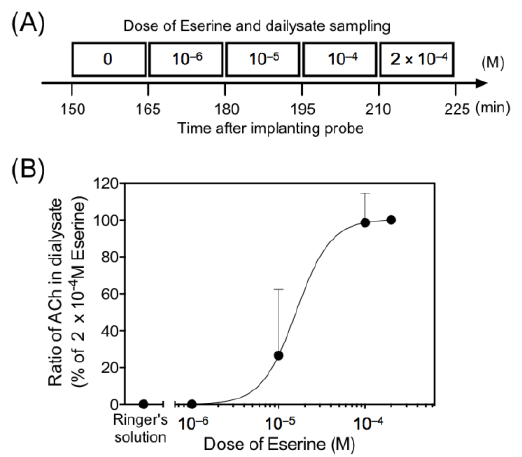
Figure 3. ( A ) A time course of sequential perfusion with different doses of Eserine and dialysate sampling. ( B ) The effect of Eserine perfusion on the extracellular concentration of acetylcholine (ACh) in rat submandibular glands. The values represent mean ± SD of 4 rats and are expressed as percentages of the acetylcholine levels obtained by perfusion with 2 × 10 −4 M Eserine.